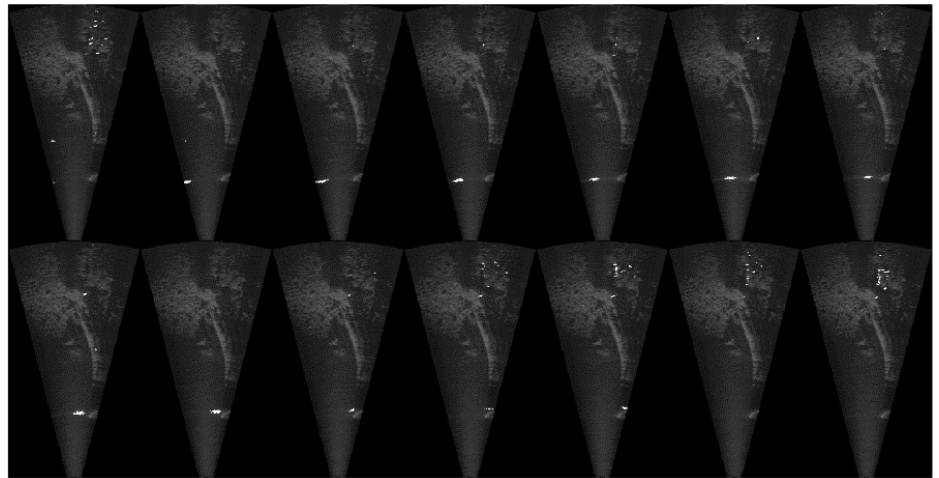
Figure 9. Sample frame subsequence displaying the determined mask superimposed on the original corresponding video frames. White represents masked areas.